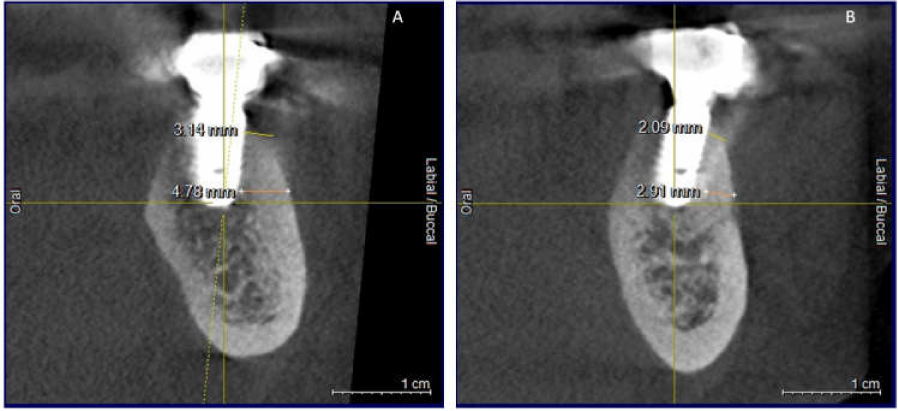
Figure 11. ( A , B ) CBCT aspects (cross-sectional) of osseointegrated implants at 24-months